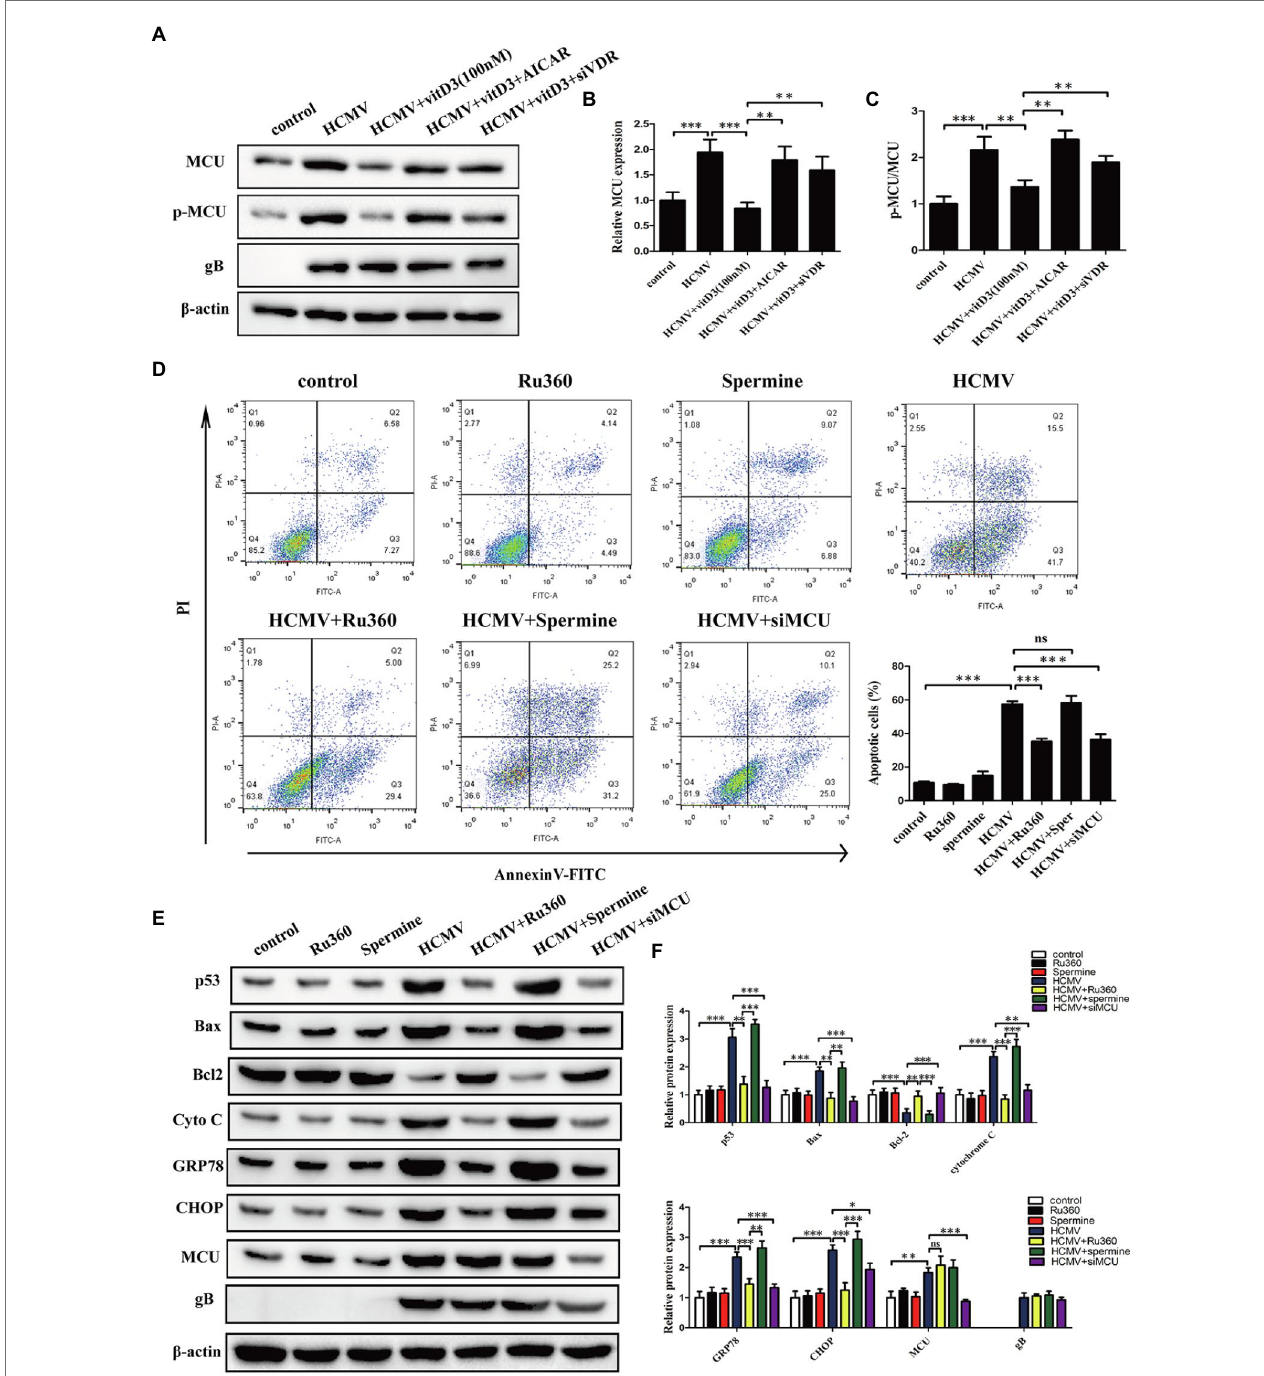
FIGURE 4 | Vitamin D3 reduces MCU expression via the VDR/AMPK pathway and MCU contributes to HCMV-induced apoptosis. (A) Representative Western blotting graphs verify that vitD3 reduces HCMV-induced increase in MCU (phosphorylated and total MCU) expression via the VDR/AMPK pathway. (B) Statistical histogram representing a densitometric analysis performed to quantify the relative intensity of the total MCU expressive bands detected by Western blotting in (A) . (C) Statistical histogram representing a densitometric analysis performed to quantify the ratio of p-MCU to total MCU in (A) . (D) Representative Annexin-V/PI double-labeled flow cytometric assay shows that MCU inhibition attenuates the apoptosis induced by HCMV. Left, representative images of flow cytometry; right, statistical charts. (E) Representative Western blotting graphs verify that MCU inhibition attenuates the expression of apoptosis-associated proteins. HAECs were exposed to HCMV or not with or without Ru360 (5 μ M) or spermine (10 μ M). gB, a HCMV gene used to quantify HCMV infection. (F) Statistical histogram representing a densitometric analysis performed to quantify the relative intensity of the indicated bands detected by Western blotting in (E) . All data are expressed as the mean ± SD of triplicate experiments. Student’s t- test, * p < 0.05, ** p < 0.01, and *** p < 0.001. ns: no significant